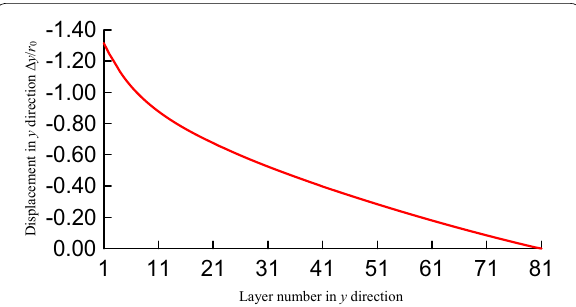
Figure 3 Displacements in y direction of atoms on the centerline of the substrate (113 ×